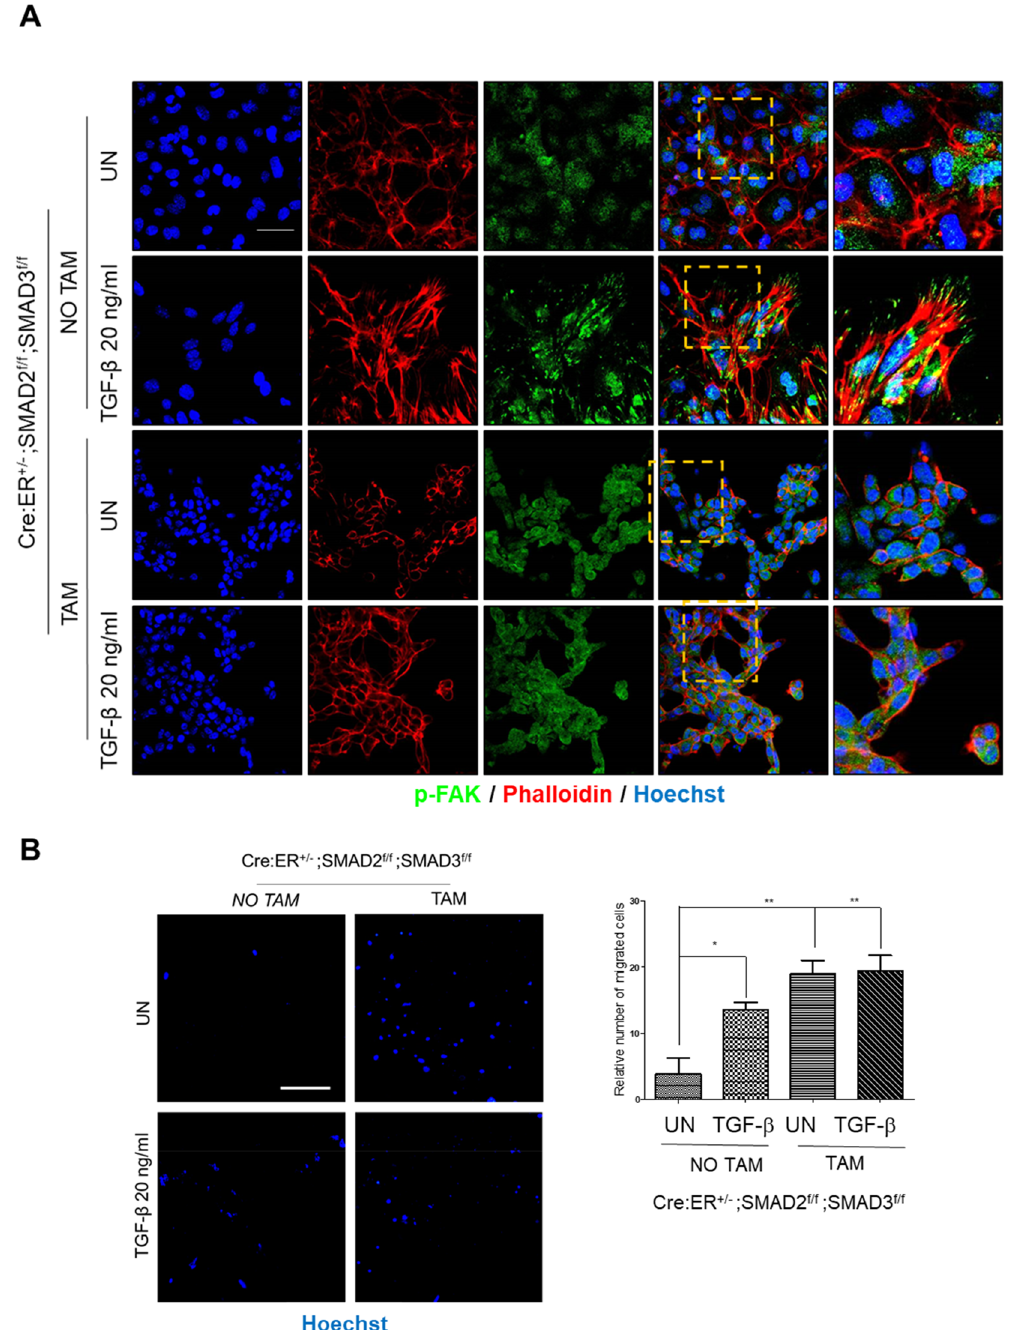
Figure 8. ( A ) Phalloidin and phosphorylated FAK (p-FAK) immunofluorescence corresponding to 2D endometrial epithelial monolayers isolated from Cre:ER +/− ; SMAD2 f/f ; SMAD3 f/f , plated and treated tamoxifen (TAM) to induce Cre:ER-mediated deletion of SMAD2 and SMAD3 alleles or left untreated (NO TAM) and then stimulated for 72 h with 20 ng/ml of TGF-β. Images were captured after 3 days of tamoxifen-induced deletion. Cells were counterstained with Hoechst to visualize nuclei. Scale bars: 25 µm. ( B ) Representative images of Hoechst staining images and quantifications of from Cre:ER +/− ; SMAD2 f/f ; SMAD3 f/f transwell assay. Cells were plated on top of transwell inserts, treated with tamoxifen (TAM) or not (NO TAM) to induce SMAD2/3 deletion and then treated with TGF-β. After 72 h migrating cells were stained with Hoechst and quantified. Scale bars: 200 µm. Values are mean and error bars represent mean ± S.E.M. *** P < 0.001 by one-way ANOVA, followed by the Tukey’s multiple comparison